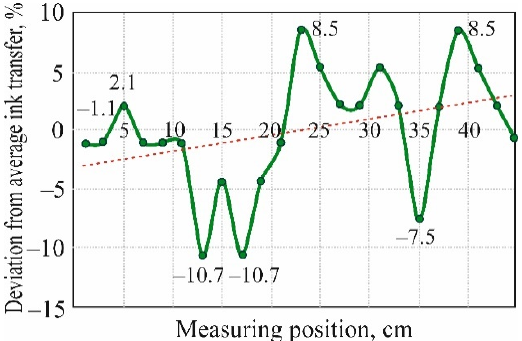
Figure 14. Change in anilox roller ink transfer along the axis. Ink transfer on the perimeter of the anilox roller was calculated by 22 measurements, resulting in an average of 2.95 cm 3 /m 2 . The measurements are expressed as percentages, where 100% is the calculated average, and the results are shown in a radial diagram in Figure 15, which simulates the perimeter of the anilox roller. Here, an even greater unevenness than in the measurements by axis can be seen—the values vary from − 22.2% to +15.1%. There is also a larger and largest difference between the two positions—between 27 and 29 cm, the change in ink transfer changes by 17.3%.